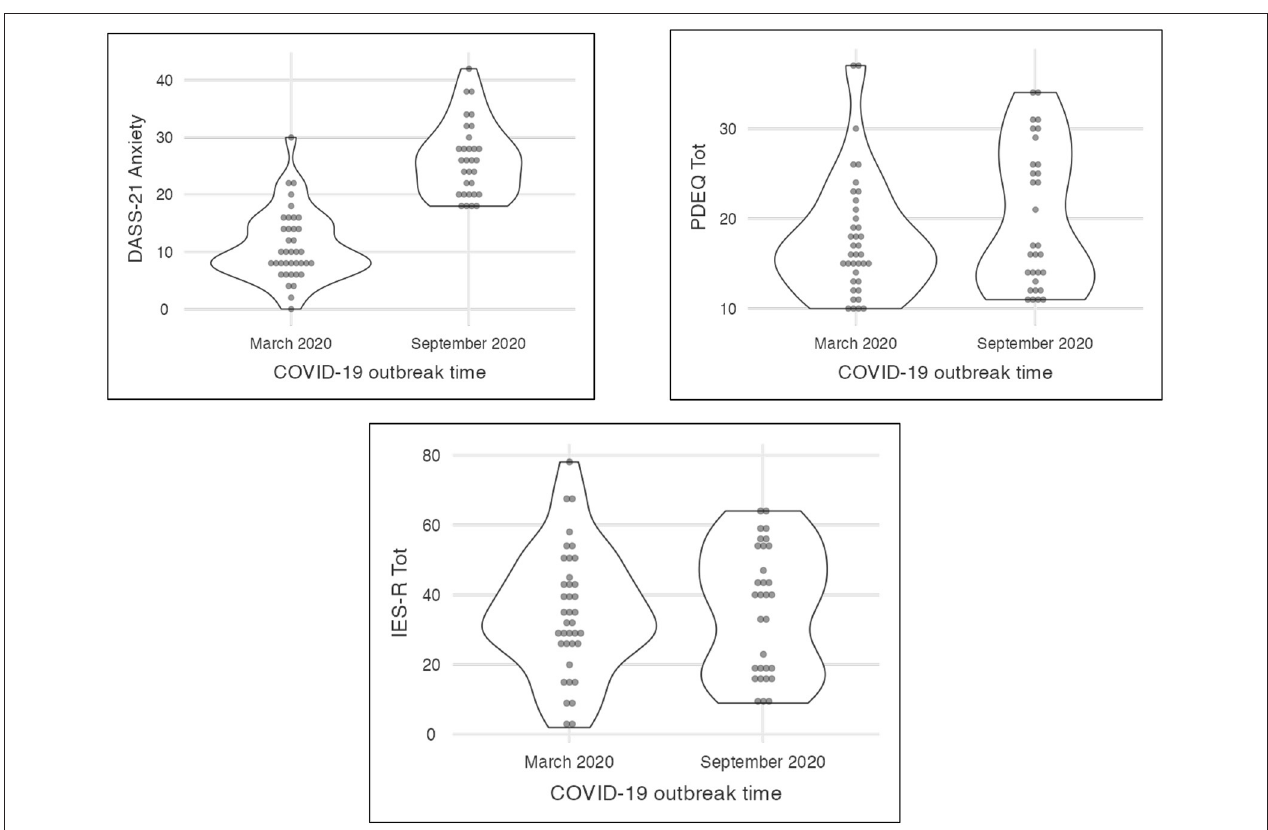
FIGURE 1 | Representation of emotional dimensions in short- and long-term COVID 19